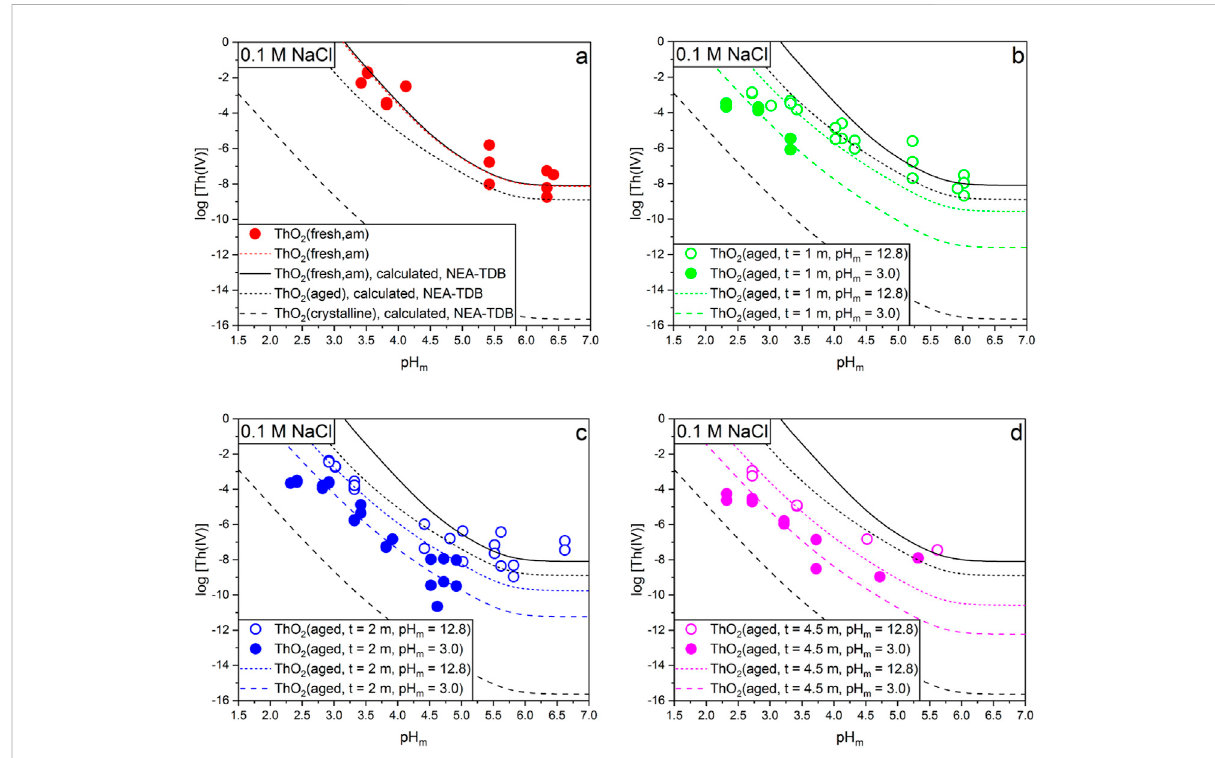
FIGURE 5 Experimental solubility data obtained in this work and model calculations using thermodynamic data derived in this work or reported in the NEA-TDB for Th(IV) hydrous oxide: (A) freshly precipitated; (B) agedfor 1m atT= 80 ° C and pH m = 3and 12.8; (C) aged for 2m atT = 80 ° C and pH m = 3 and 12.8; (D) aged for 4.5m at T = 80 ° C and pH m = 3 and